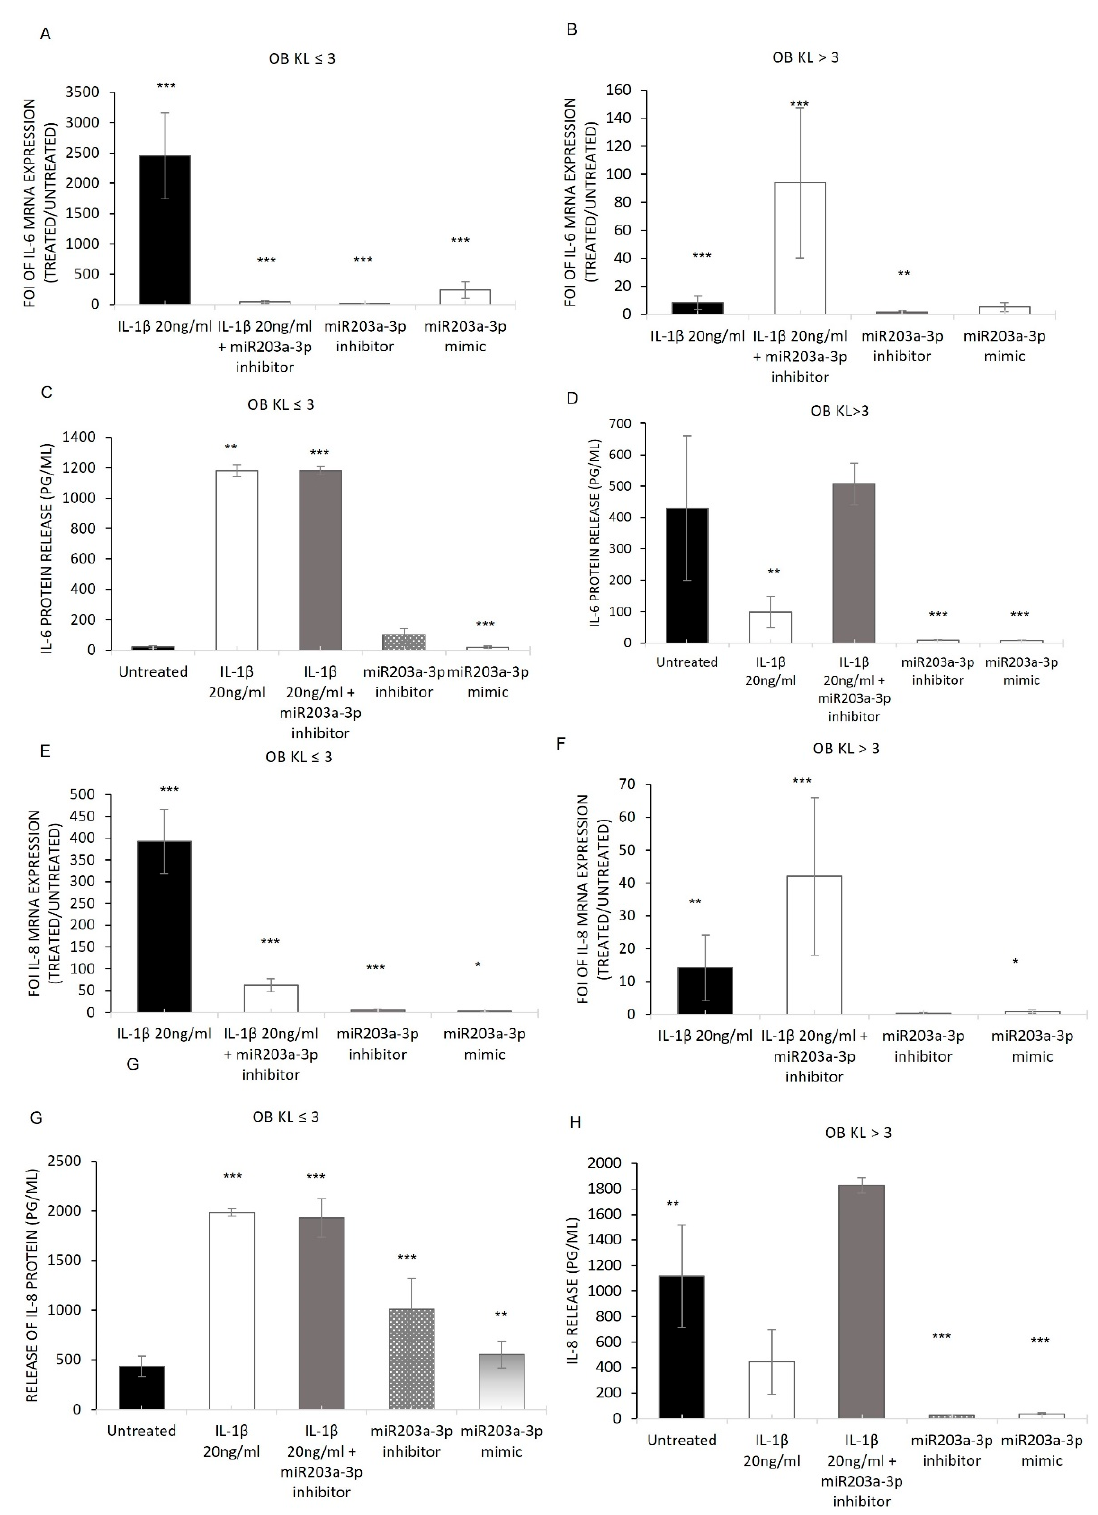
Figure 4. Gain and loss of function studies on osteoblasts derived from OA patients. Results of qRT-PCR ( A,B,E,F ) and ELISA ( C,D,G,H ) analysis of IL-6 and IL-8 mRNA expression levels on OBs derived from patients with KL ≤ 3 and KL > 3 treated with IL-1 β and co-treated with IL-1 β and inhibitor transfection, miR203a-3p inhibitor transfection, and miR203a-3p mimic transfection (mean ± SD, n = 4). One-way ANOVA; multiple comparisons versus untreated (* p < 0.05; ** p < 0.005; *** p <